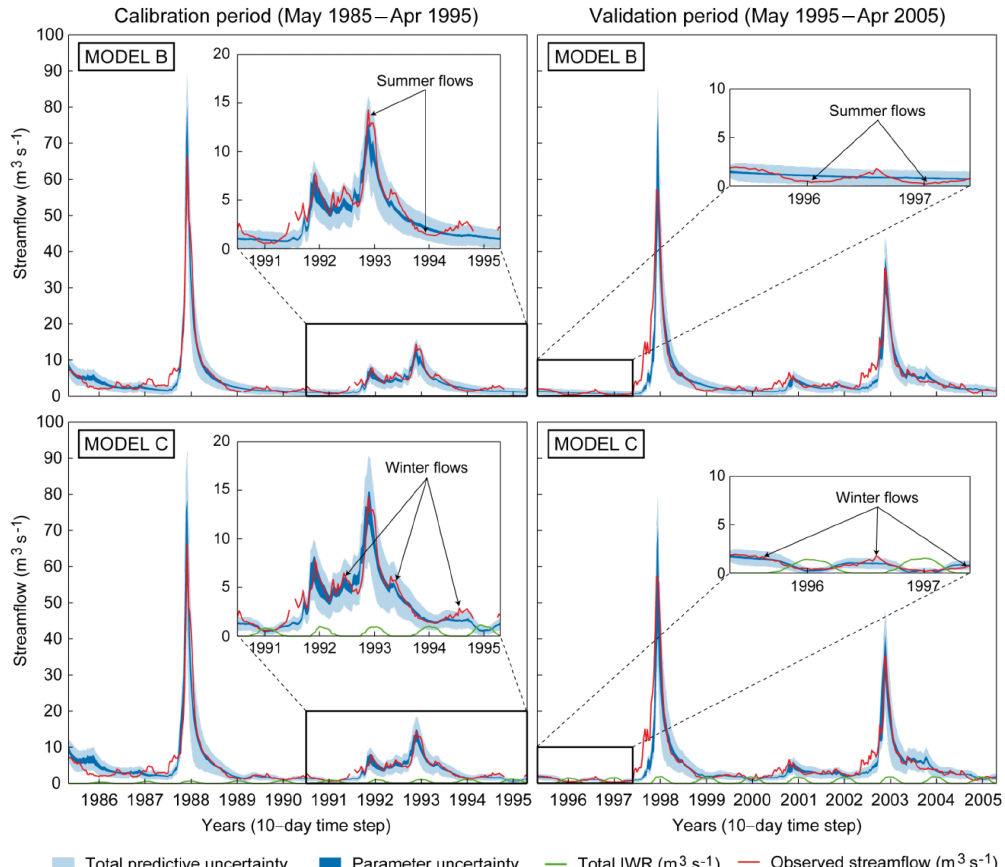
Figure 10. Predictive uncertainty bands obtained for Models B and C with the DREAM algorithm and GL function. The dark blue region represents the 95% confidence intervals associated with parameter uncertainty, whereas the light blue region represents the 95% confidence intervals associated with parameter, model structure and input errors. The tick values on the x axis indicate 1 January of each